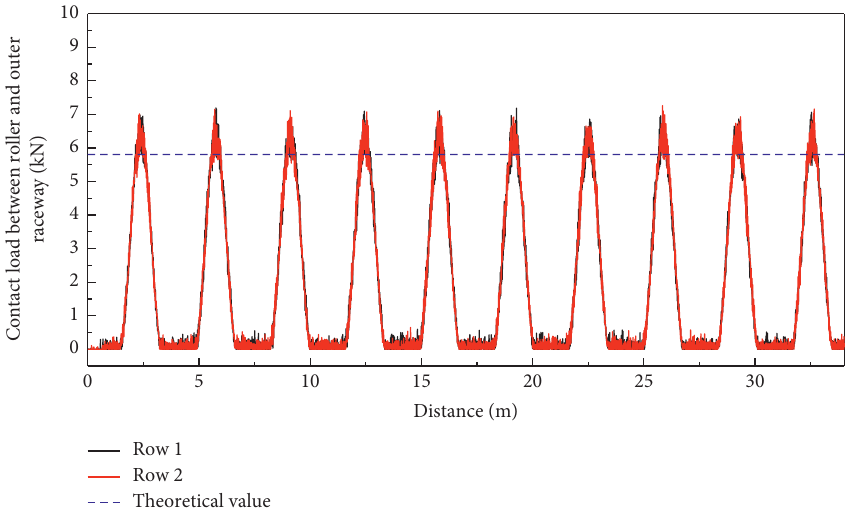
Figure 9: Contact load history of the roller and outer